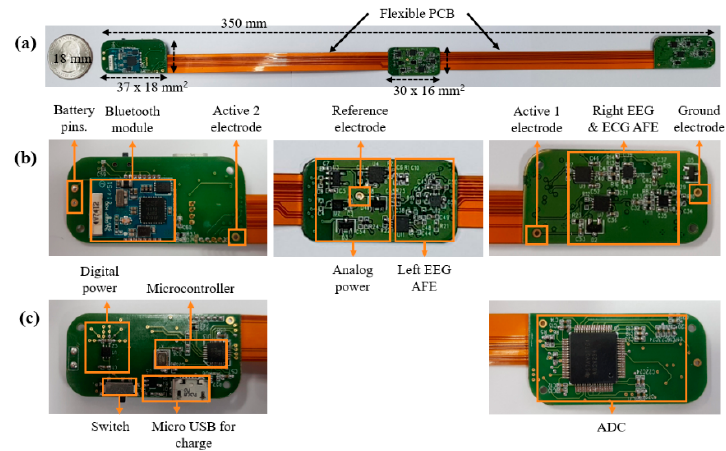
Figure 6. Photographic image of the printed circuit board of the wearable EEG and ECG recording system. ( a ) View of all printed circuit boards (PCBs), in which the three rigid PCBs are connected by flexible PCBs. ( b ) Enlarged view of the top side of the PCBs and their component layouts. ( c ) Enlarged view of the bottom side of the PCBs and their component layouts.